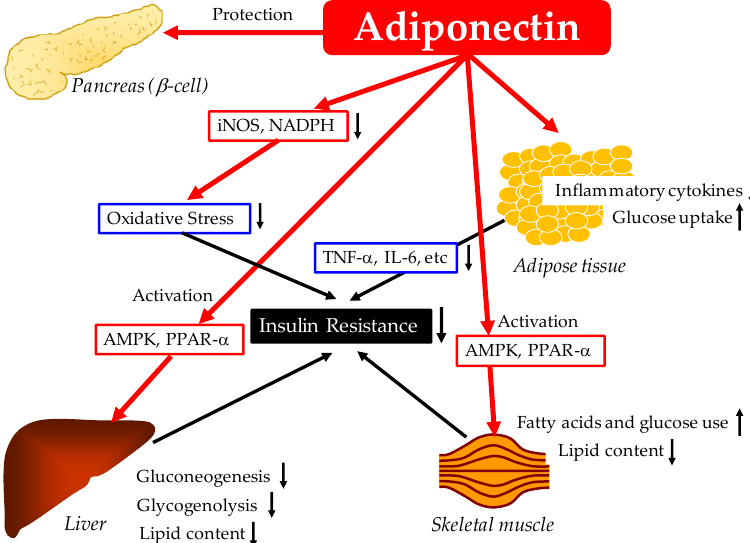
Figure 1. Possible mechanisms for the improvement of glucose metabolism by adiponectin. AMPK, adenosine monophosphate-activated protein kinase; IL-6, interleukin-6; iNOS, inducible nitric oxide synthase; NADPH, nicotinamide adenine dinucleotide phosphate; PPAR- α , peroxisome proliferator-activated receptor- α , TNF- α , tumor necrosis factor- α.